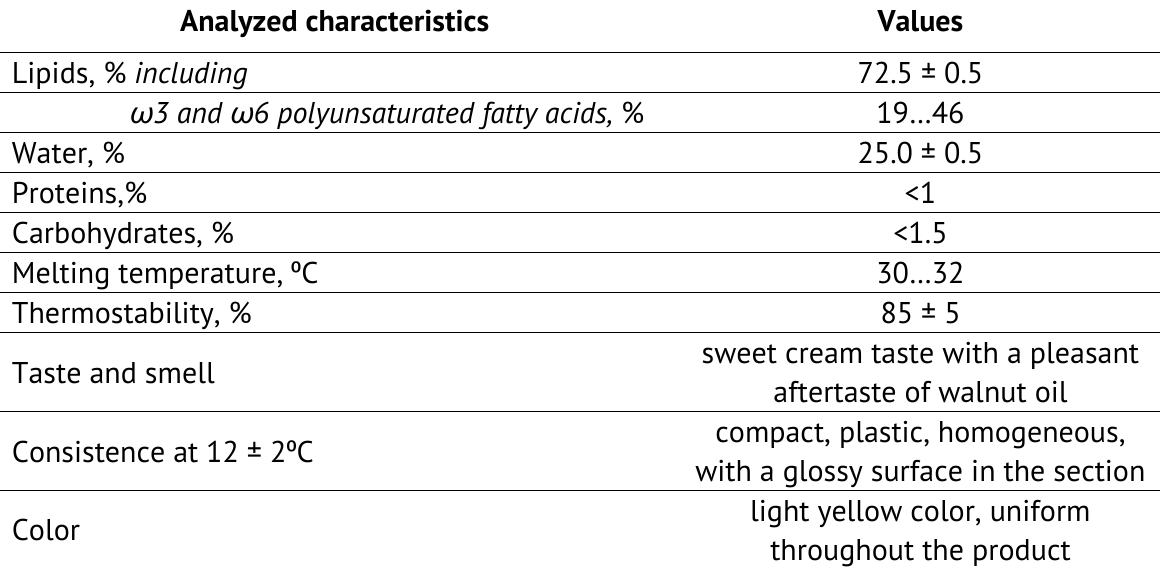
Characteristics of spread based on walnut oil